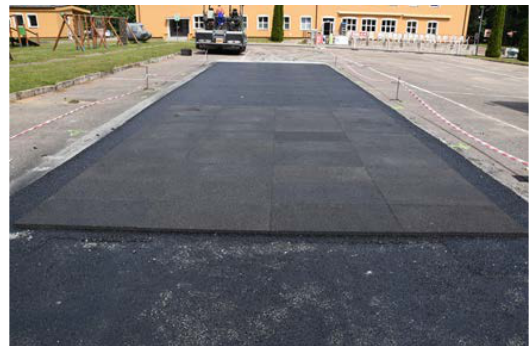
Figure 16. Slabs of Poroelastic Road Surfaces (PERS) polyurethane poroelastic mixture after installation.